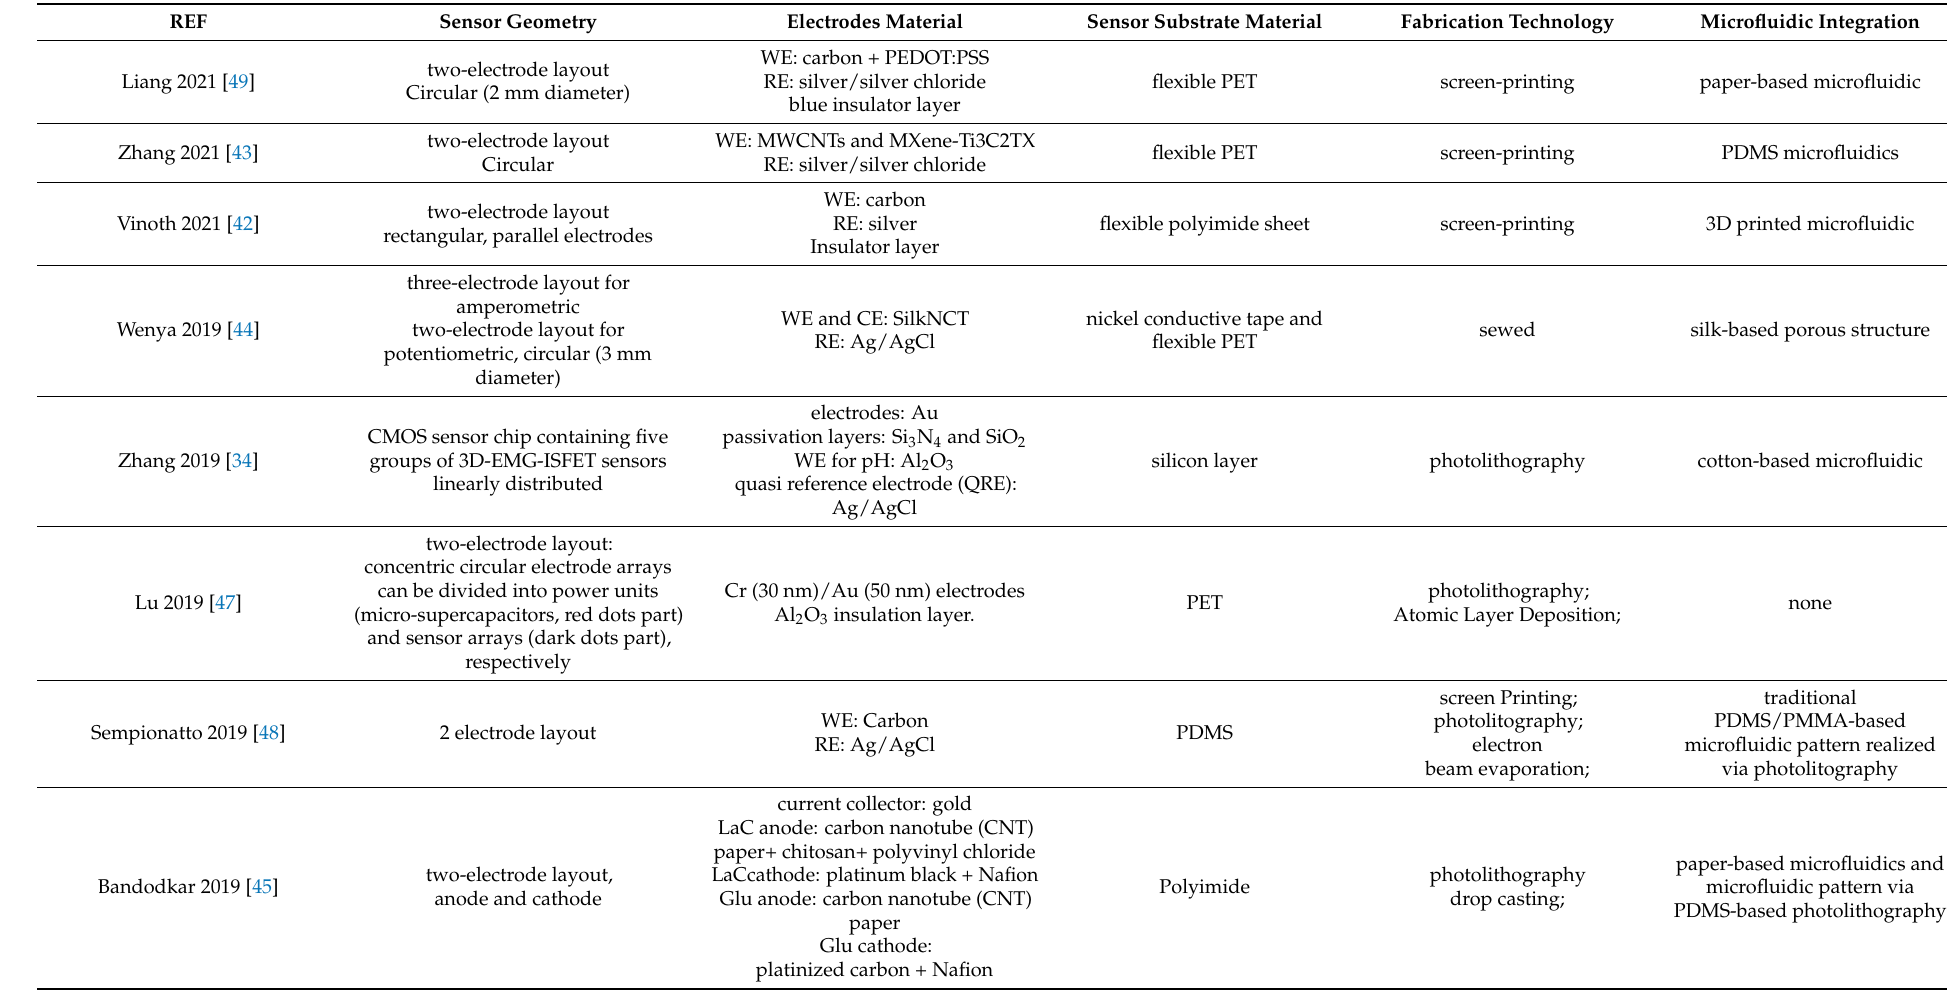
Table 2. Summary of biosensors specific